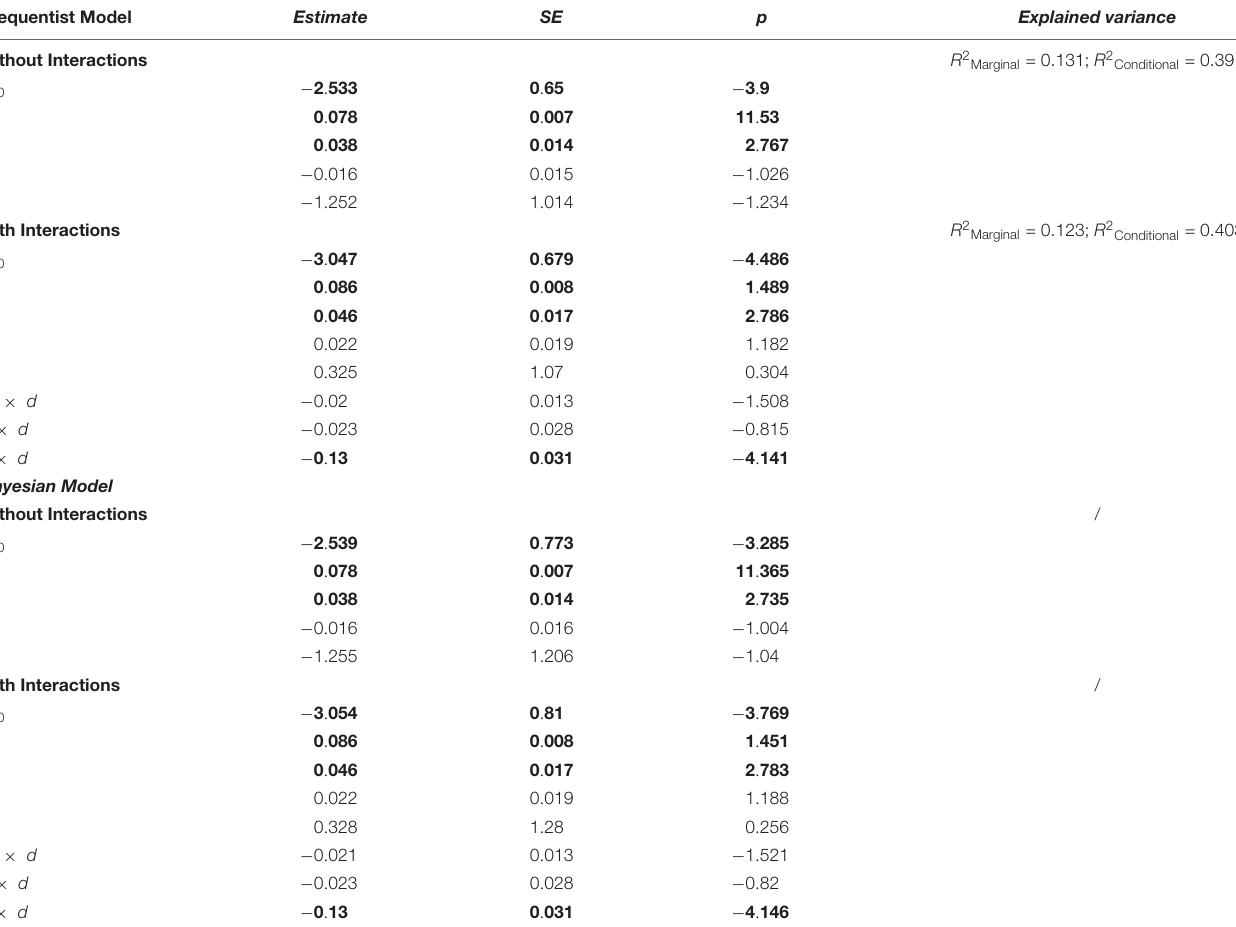
TABLE A2 | Predictiveness of different factors (i.e., ml , g , rl , and d ) regarding the criterion cogIll in four different models (frequentist and Bayesian, both with and without interactions) without the Linda task. Frequentist Model Estimate SE p Explained variance Without